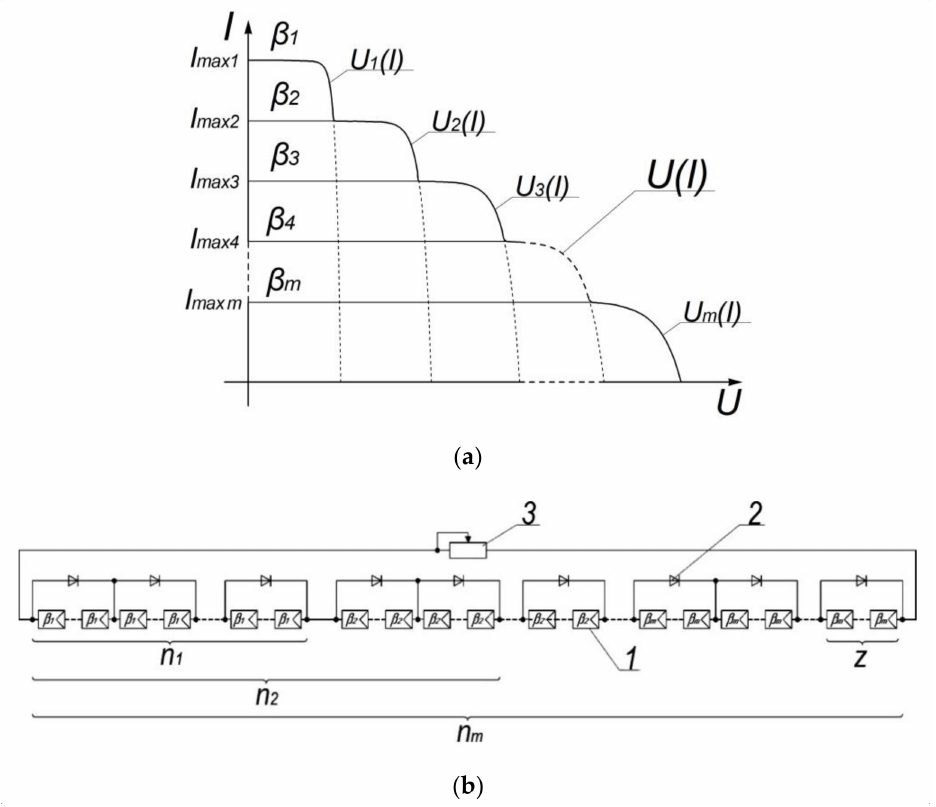
Figure 3. Current-voltage characteristic of an unevenly illuminated array of solar cells ( a ) and its structural diagram ( b ) (1—solar cell; 2—shunt diode;